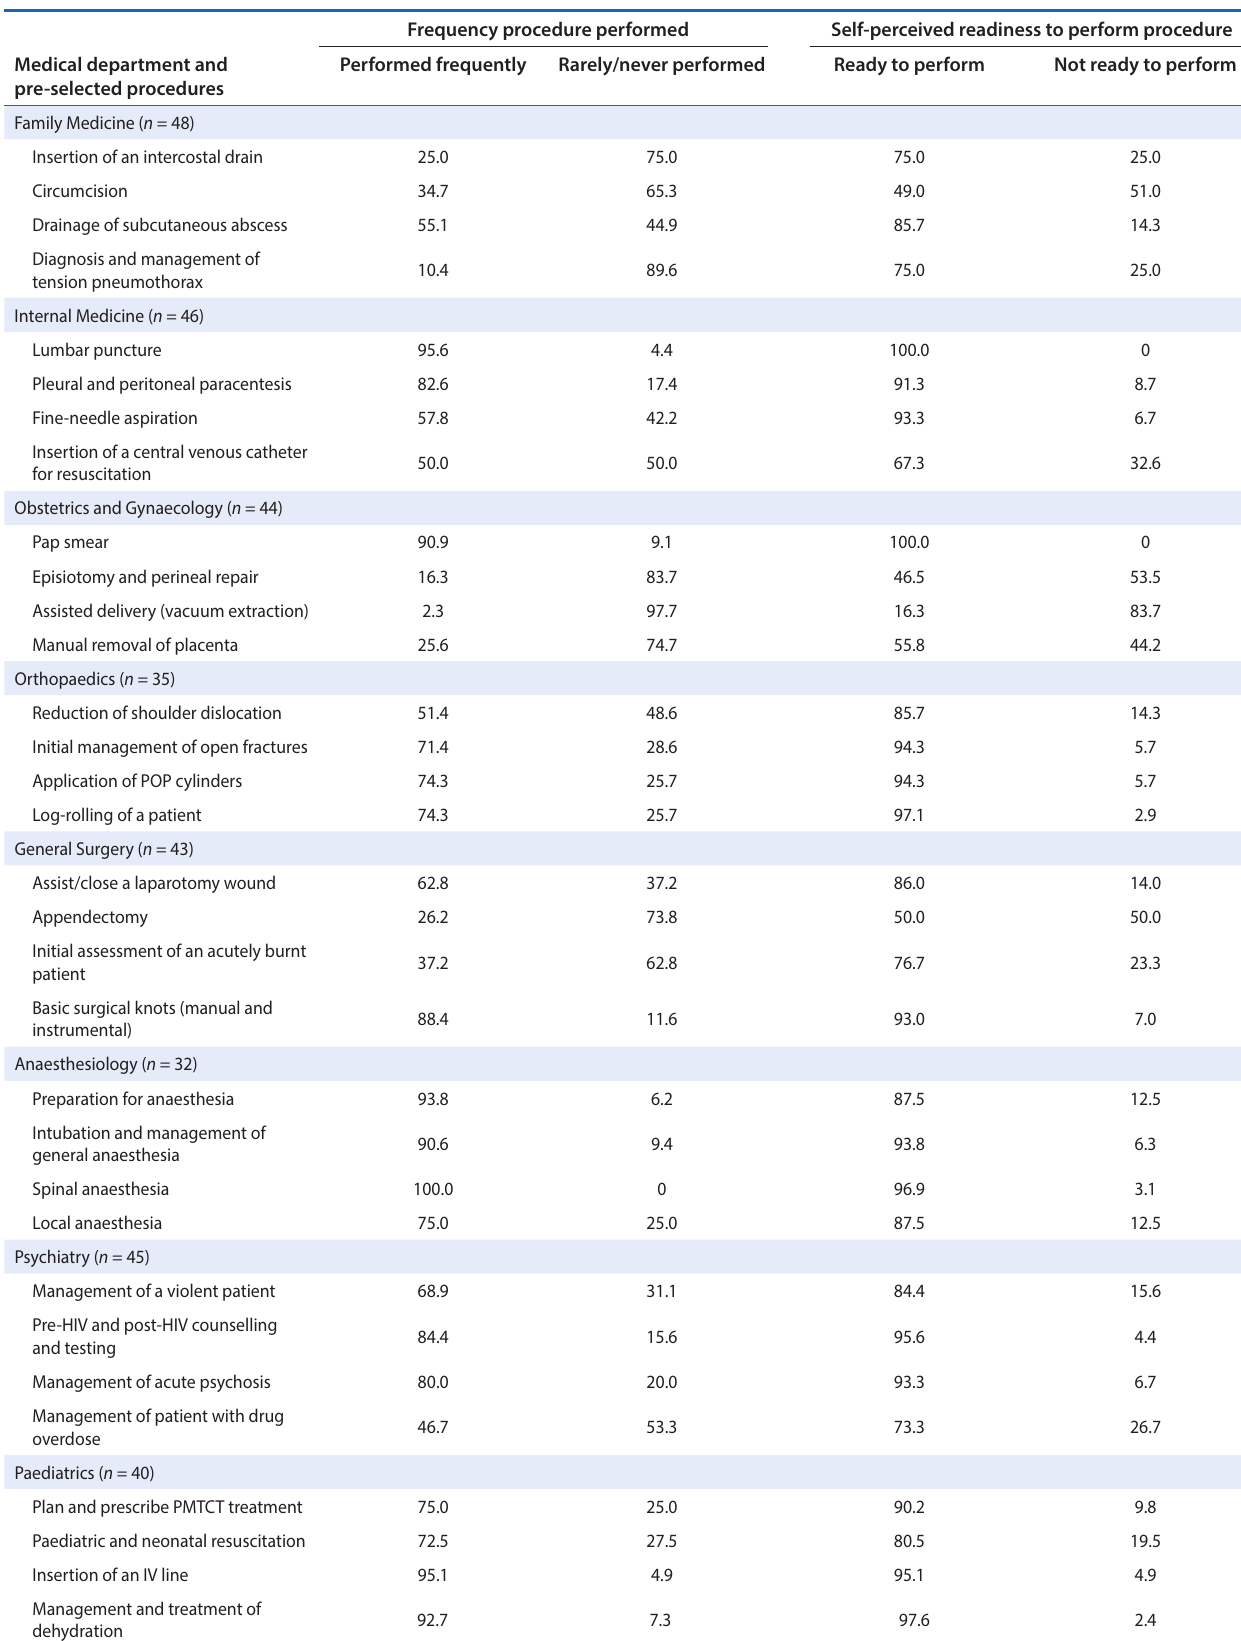
Table 2: Procedures performed and perception of readiness per department